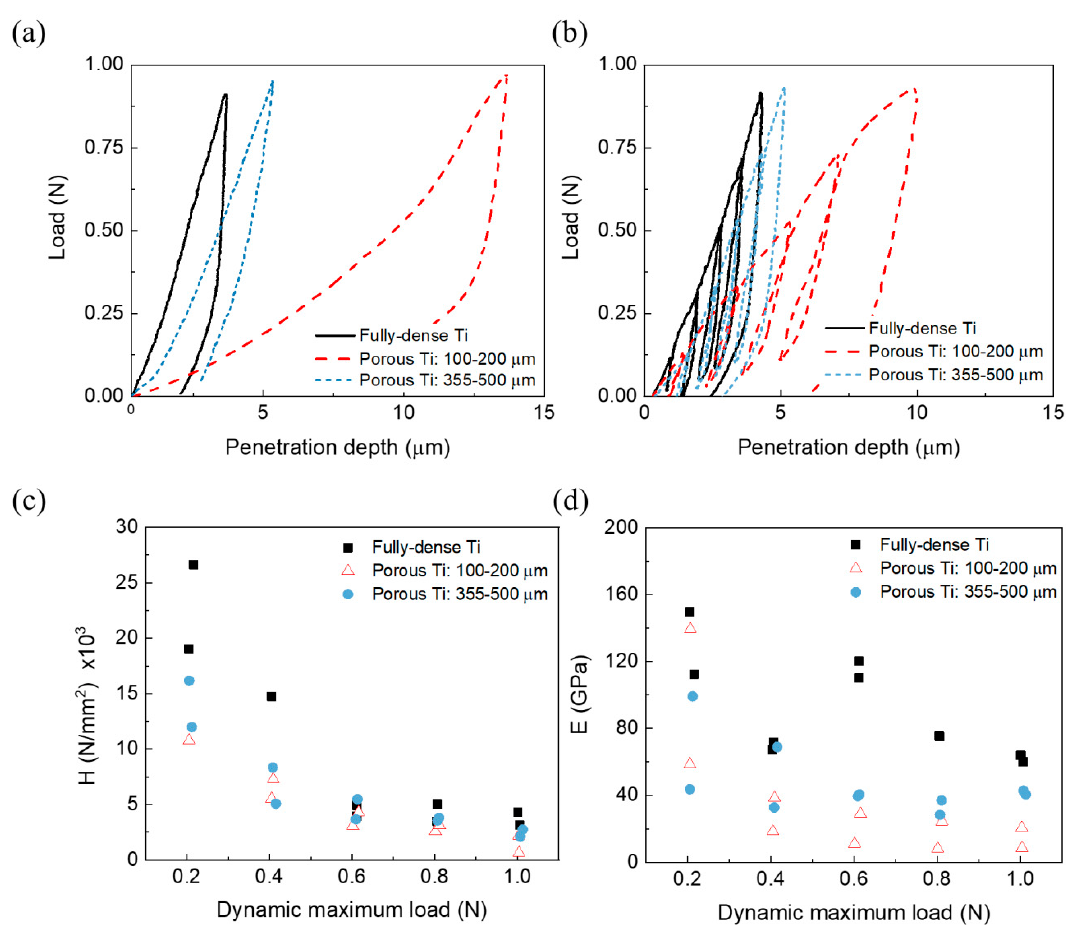
Figure 5. Instrumented micro-indentation of fully-dense and porous titanium substrates: ( a ) Loading– unloading curves ( P-h curves) under static and ( b ) dynamic loads, as well as the ( c , d ) mechanical properties (micro-hardness and Young’s modulus) as a function of penetration depth (dynamic conditions).